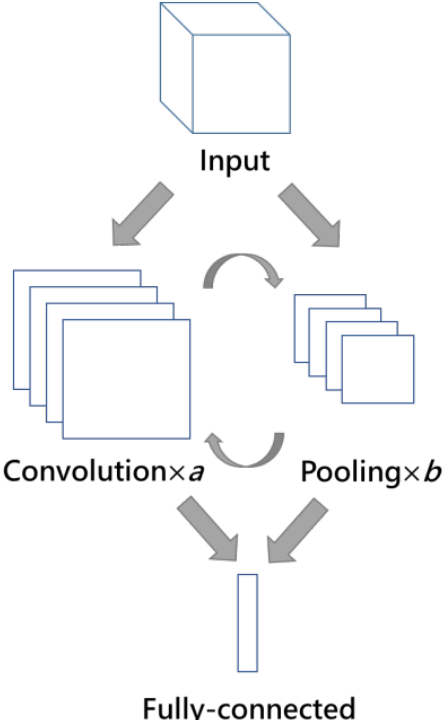
Figure 2. Convolutional neural network (CNN) architecture.